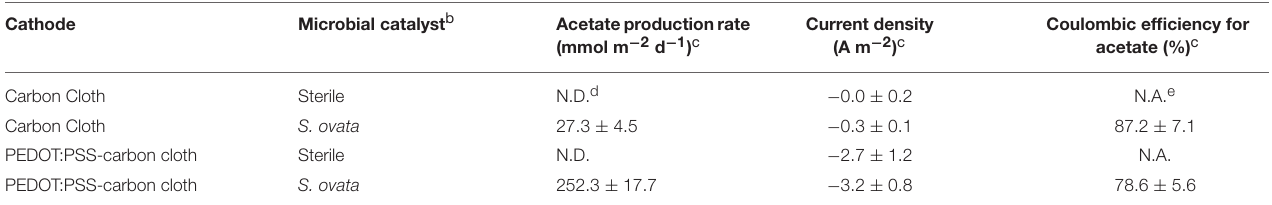
TABLE 1 | MES performance with PEDOT:PSS-carbon cloth cathode a